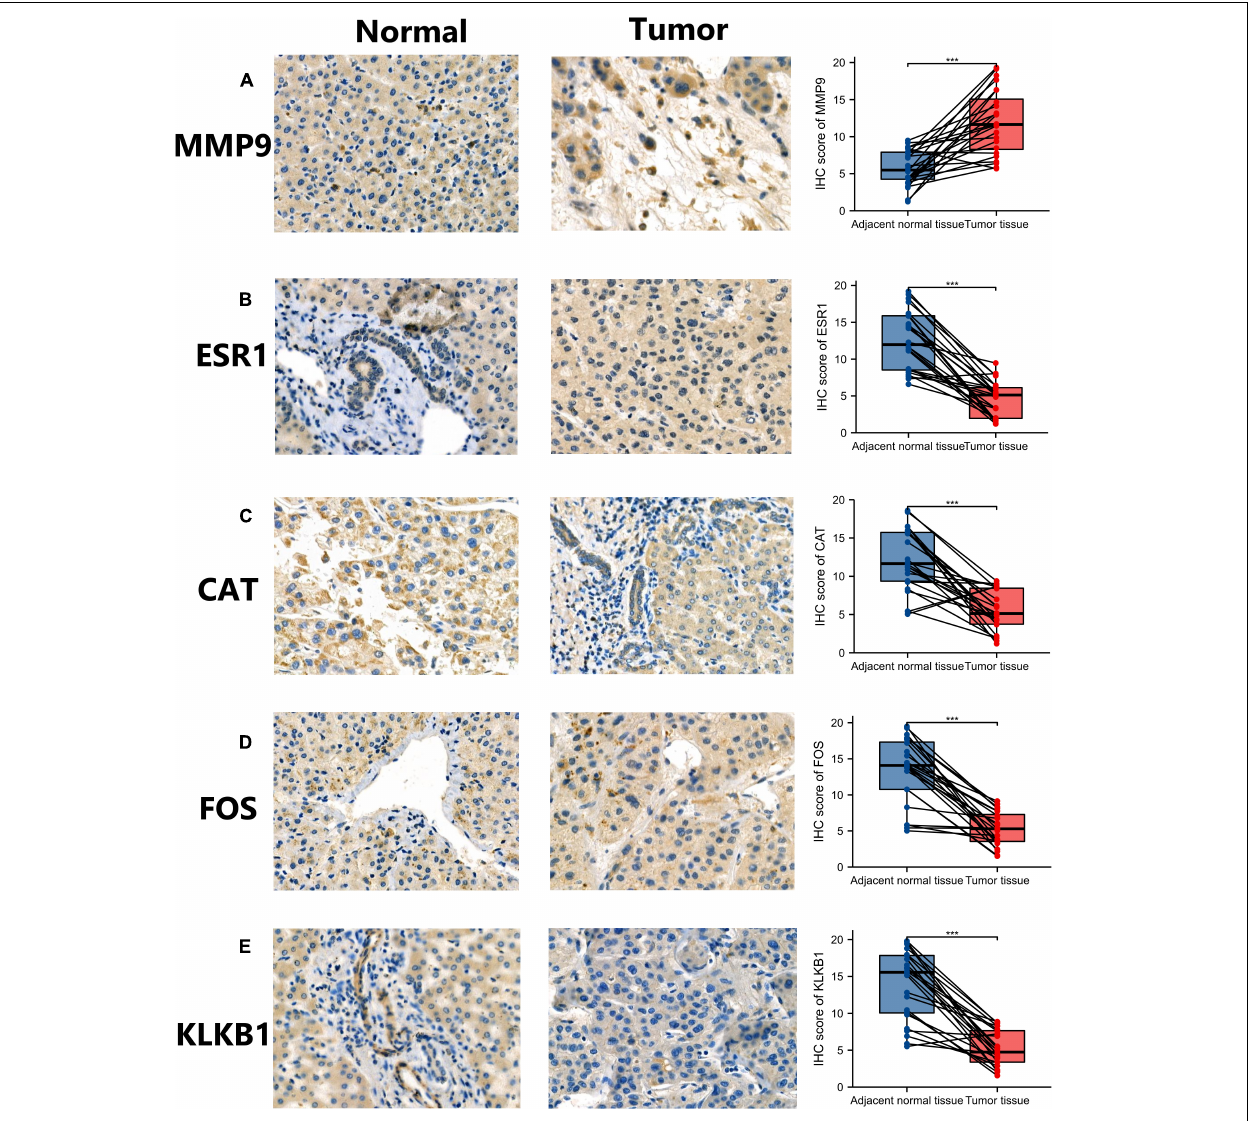
FIGURE 3 | Validation of the expression of characteristic immune-related genes (IRGs) in hepatocellular carcinoma (HCC) by immunohistochemistry (IHC). Panels (A–E) are the results of IHC and semi-quantitative analysis of MMP9, ESR1, CAT, FOS, and KLKB1 in HCC tissues and adjacent normal tissues, respectively. * p < 0.05; ** p < 0.01; *** p <